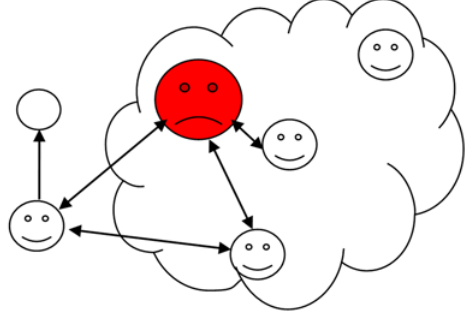
Figure 3. Harvesting attack. If there is a powerful server (possibly run by adversaries), all nodes would try to connect that server; thus, the entire network would be